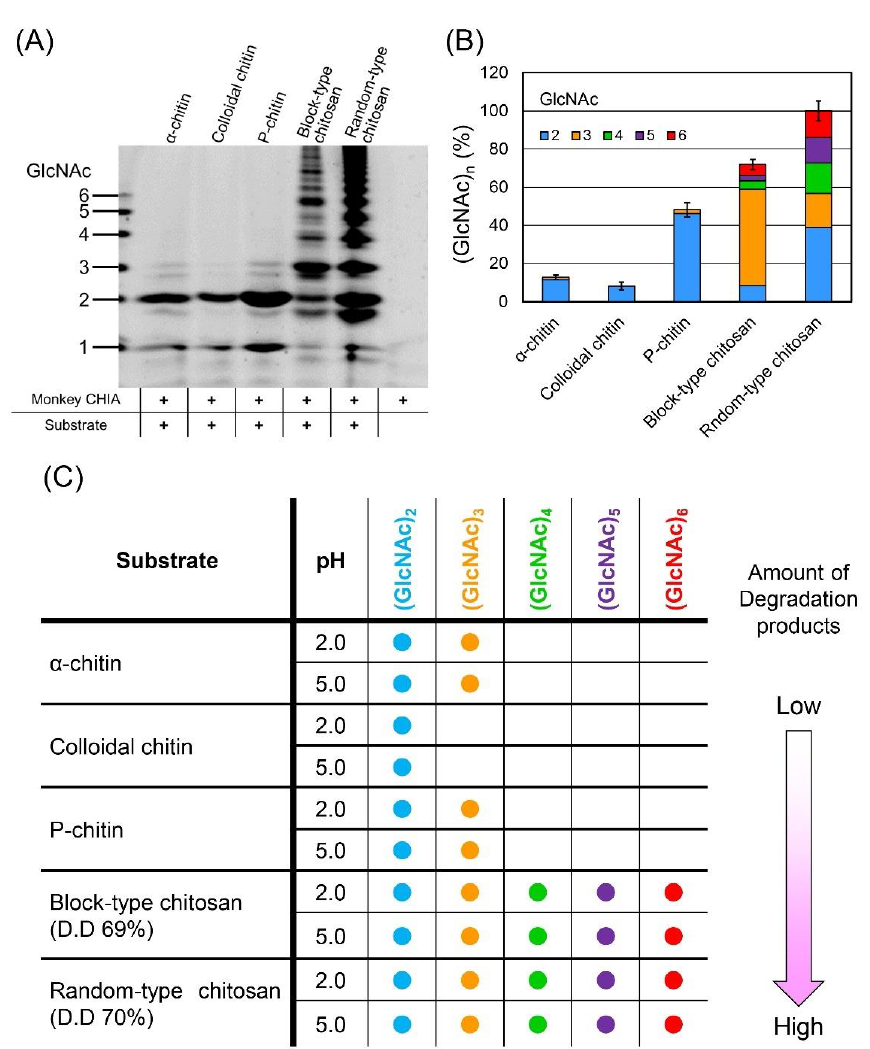
Figure 4. Comparison of degradation patterns of chitin and chitosan substrates. Five substrates were incubated with monkey CHIA at pH 5.0 and 50 °C for 72 h. Those included α -chitin, colloidal chitin, P-chitin, and block-type and random-type chitosan. ( A ) FACE analysis of chitin and chitosan deg- radation by monkey CHIA. Full-length gel images are shown in Supplementary Figure S8. Size standards on the left margin are defined as chitin oligomers. ( B ) Quantitative data of (GlcNAc) 2 – 5 were obtained from each substrate. The results are shown in Supplementary Table S1. The quanti- tative data that express the percentage of the maximum signal of degradation products (the total amount of degradation products from random-type chitosan) was set to 100%. Error bars represent mean ± standard deviations from a single experiment conducted in triplicate (Supplementary Figure S9). ( C ) Qualitative analysis of the produced chitooligosaccharides from each substrate.